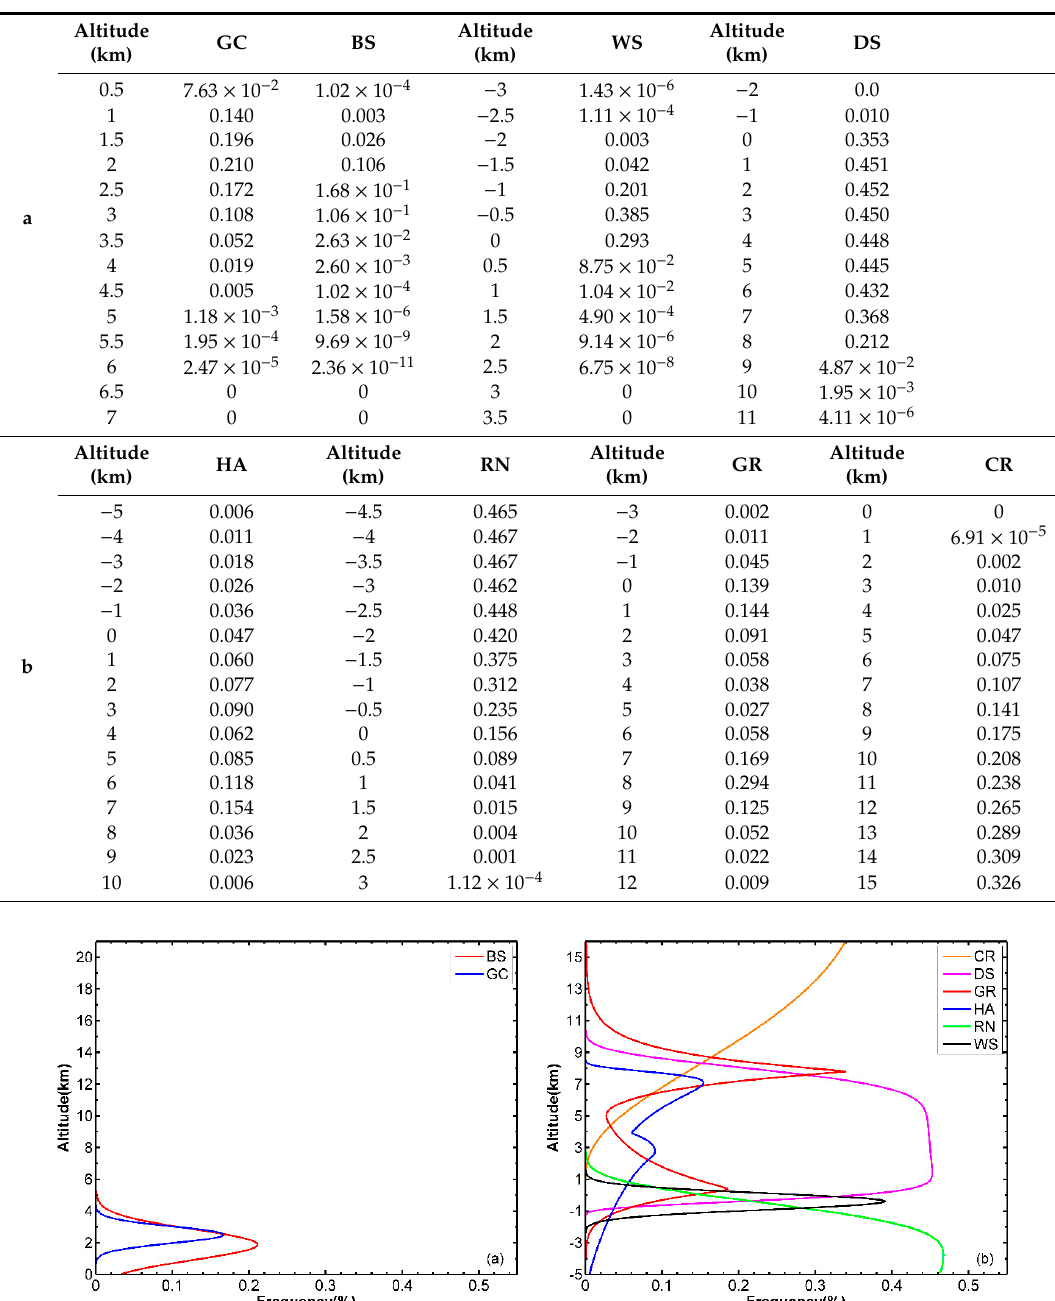
Table 4. ( a ) Fitted function of the prior PDFs for hydrometeor types GC, BS, WS and DS. Altitude for GC and BS is relative to the mean sea level, altitude for WS and DS is relative to the freezing level. ( b ) Fitted function of the prior PDFs for hydrometeor types: HA, RN, GR and CR. “Altitude” indicates altitude above mean sea level of freezing level.